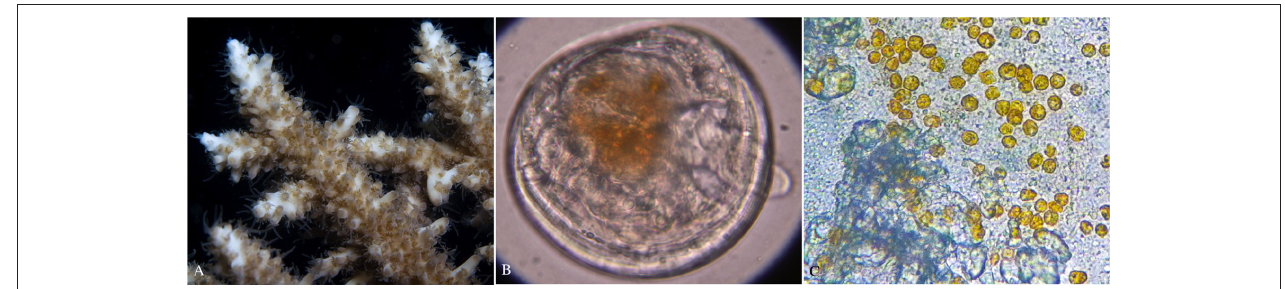
FIGURE 2 | Symbiodinium cells in both adult and larval host tissues. (A) Reef-building acroporid coral with brown coloration due to the presence of Symbiodinium , (B) Symbiodinium cells (orange-brownish area) in the digestive tract of a pediveliger larva of the giant clam Tridacna crocea , and (C) Symbiodinium cells in the gastrovascular cavity of a planula larva (squashed under a microscope) of the reef-building coral Mussismilia hispida